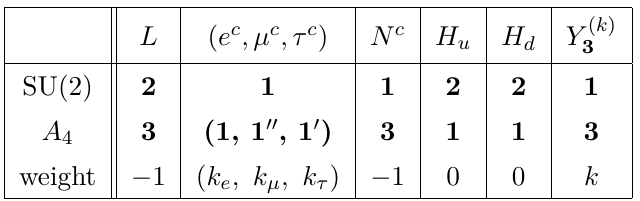
Table 1 . Representations and weights for MSSM fields and relevant modular forms of weight k